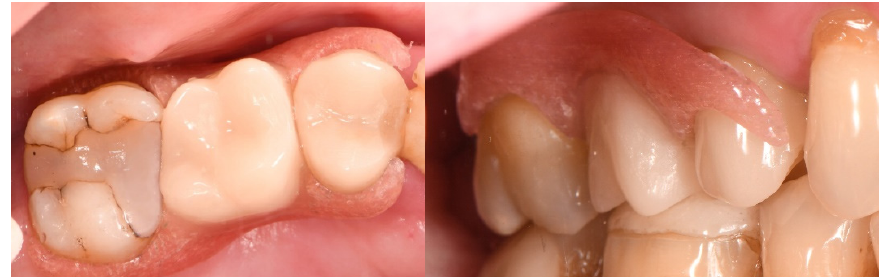
Figure 5. The final provisional denture in situ.